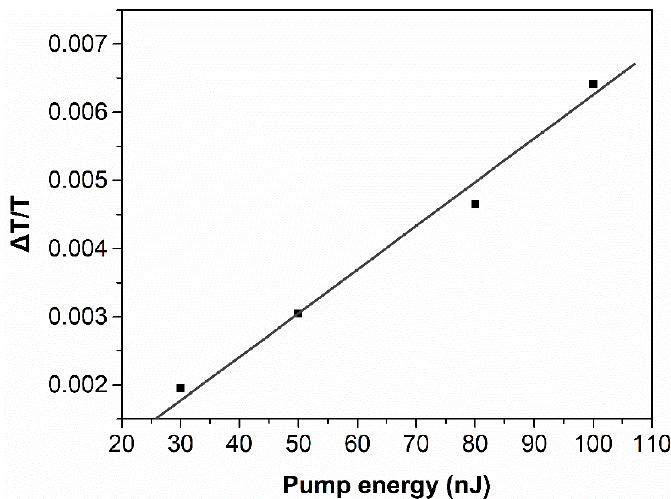
Figure 5. Pump pulse energy increases with peak value Δ T/T .